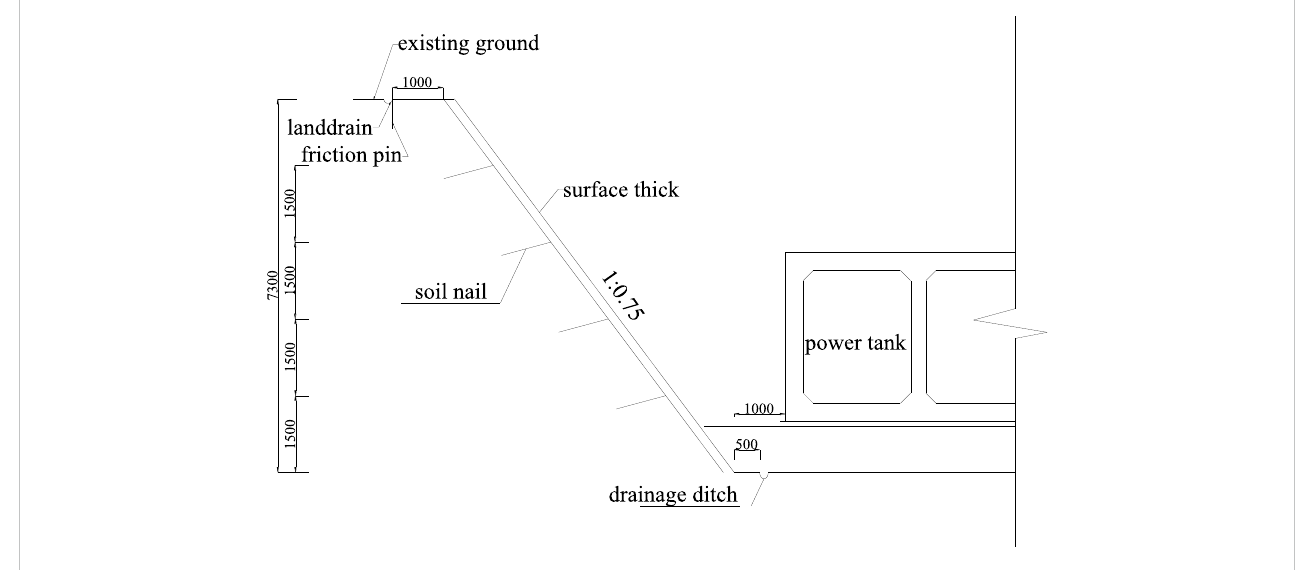
FIGURE 3 Schematic diagram of the left half of the pipe gallery (unit: mm).